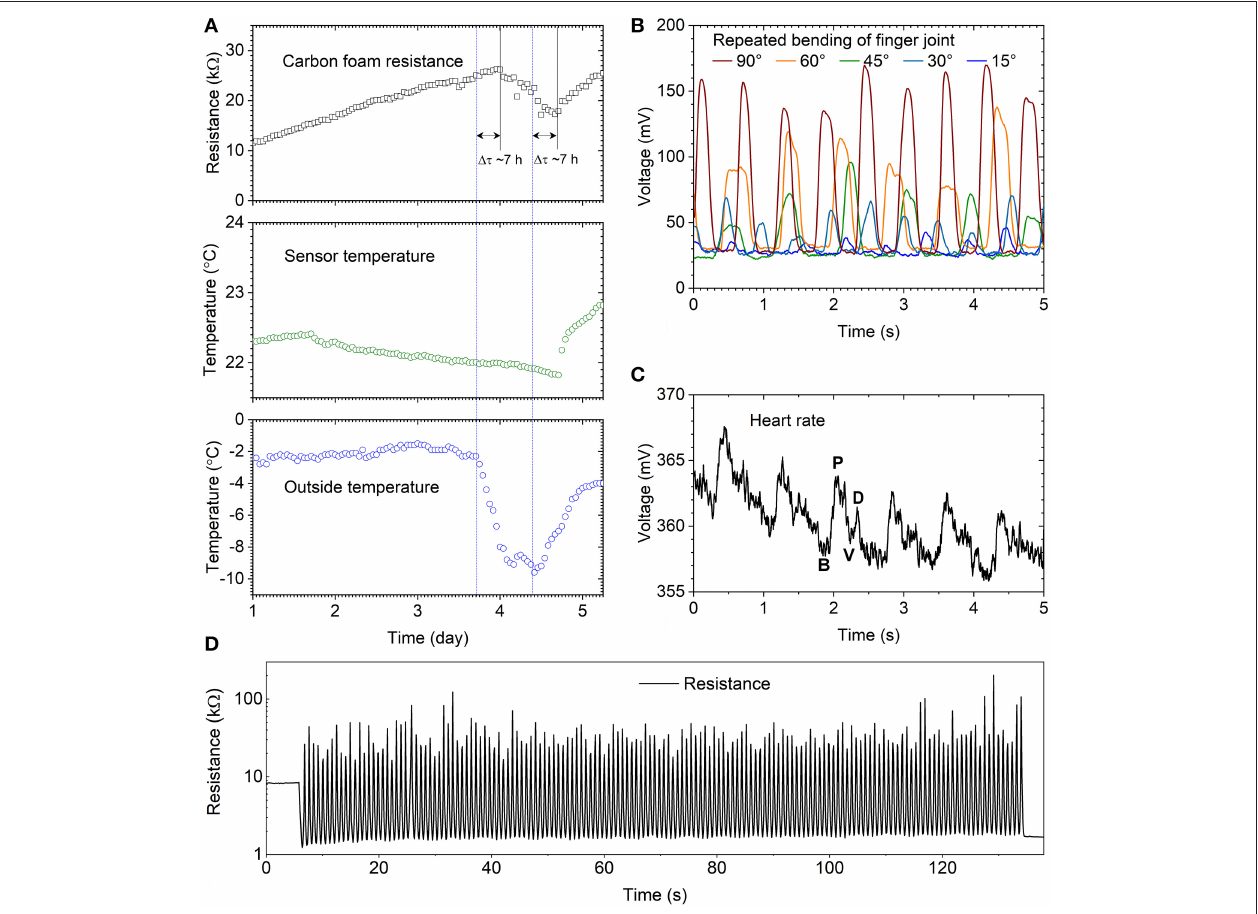
FIGURE 3 | Carbon foam based sensors monitoring displacements with highly diverse nature: (A) relative displacement of adjacent building walls constructed on separate concrete foundations, (B) repeated flexing of the index finger joint between the middle and proximal phalanges, and (C) heart rate monitored on the radial artery (B: base point, P: percussion wave, V: valley and D: dicrotic wave). (D) Resistance of a cube shaped foam under mechanical compression cycling (160 repetitions at 30%